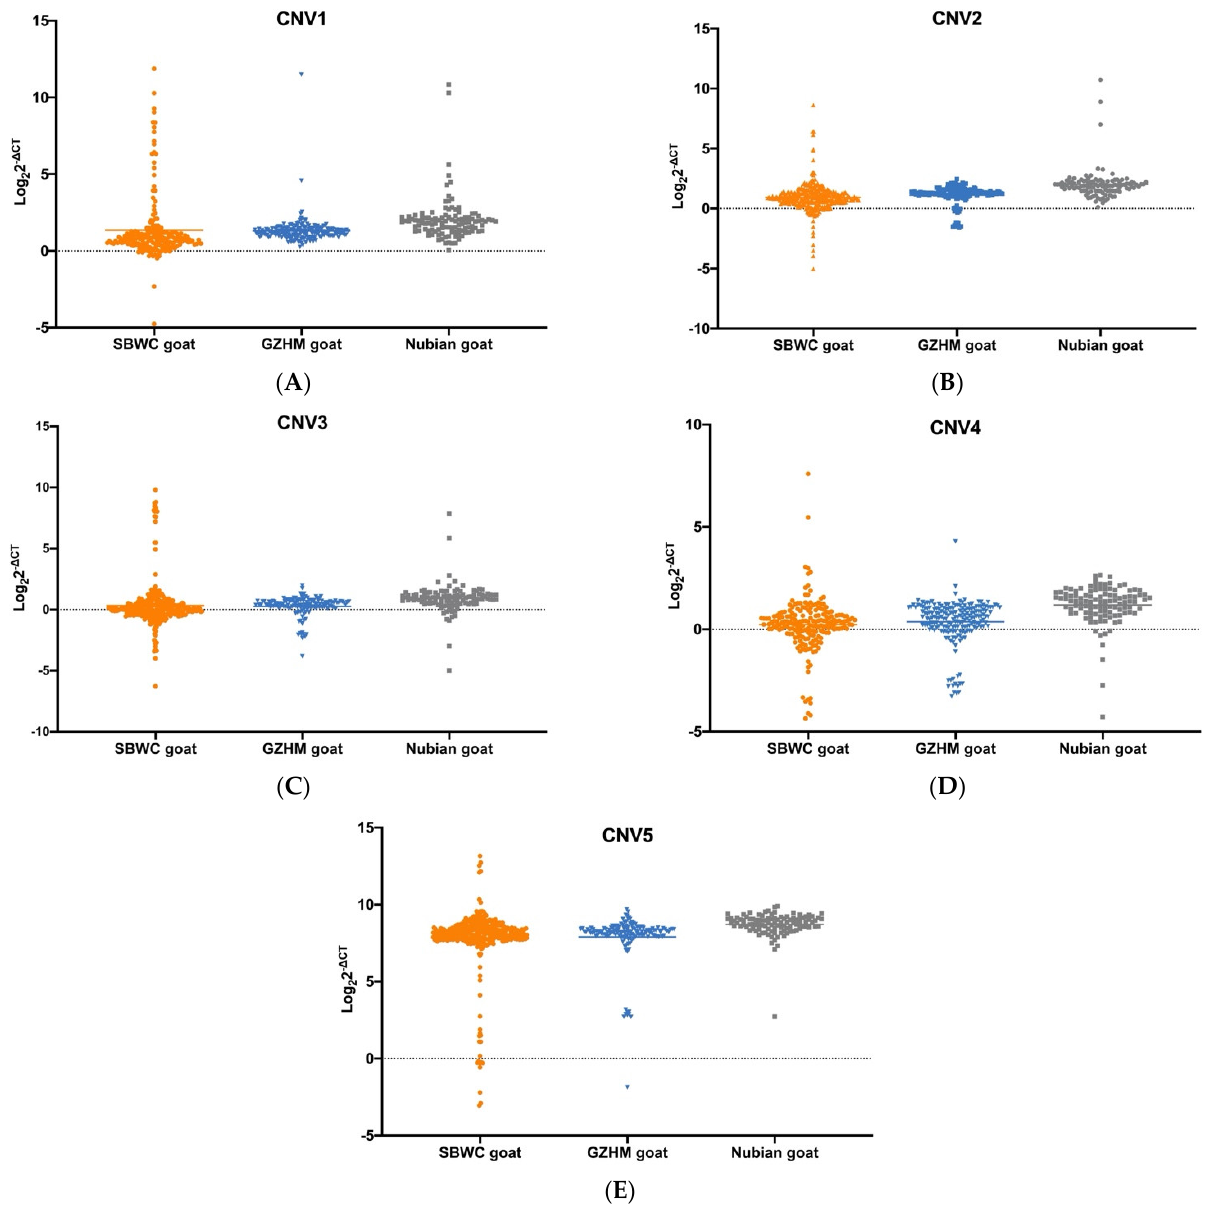
Figure 1. Distribution of different CNVs within the goat Fec B gene with respect to the vertical axis in SBWC, GZHM, and Nubian goats: ( A ) CNV1, ( B ) CNV2, ( C ) CNV3, ( D ) CNV4, ( E ) CNV5. Note: SBWC goat—Shaanbei white cashmere goats; GZHM goat—Guizhou Heima goat.